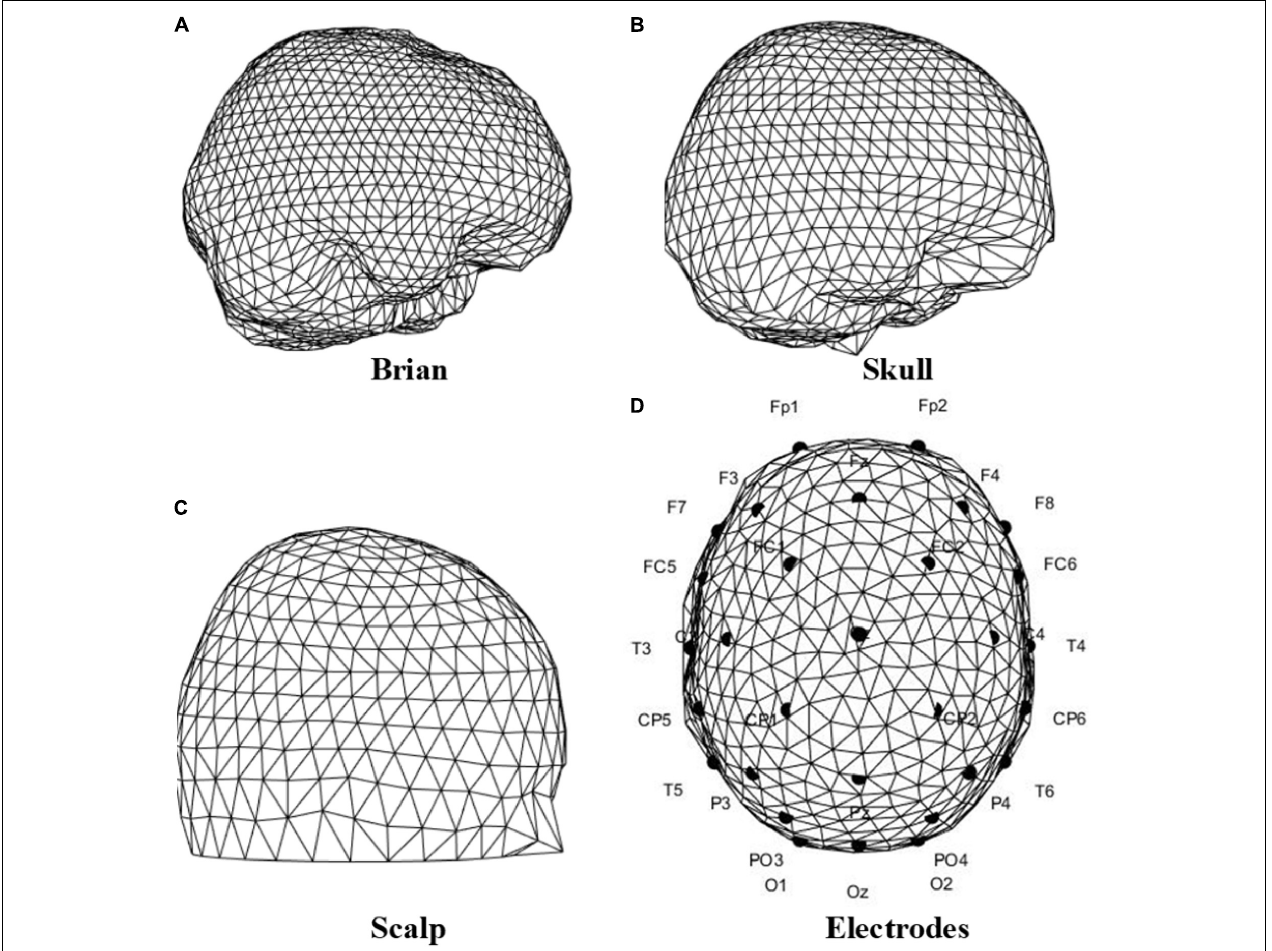
FIGURE 12 | Triangulated surfaces of the standard head model, and the electrodes location of the Neuracle device. (A) Brain. (B) Skull. (C) Scalp. (D) Electrodes location according to the Neuracle